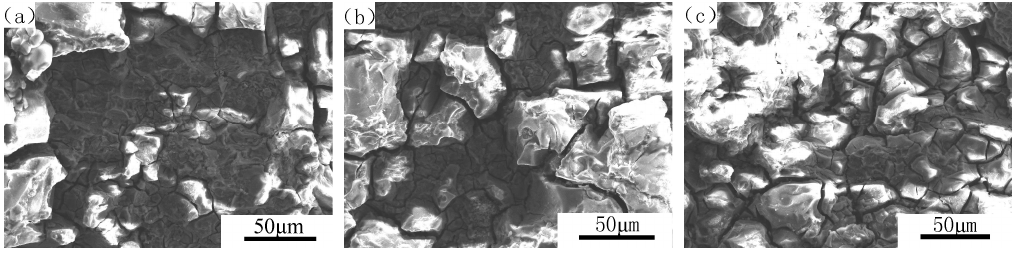
Figure 5. Fracture morphologies for 7050 aluminum alloy of three different aging states. ( a ) Over aged; ( b ) peak aged; ( c ) under aged.